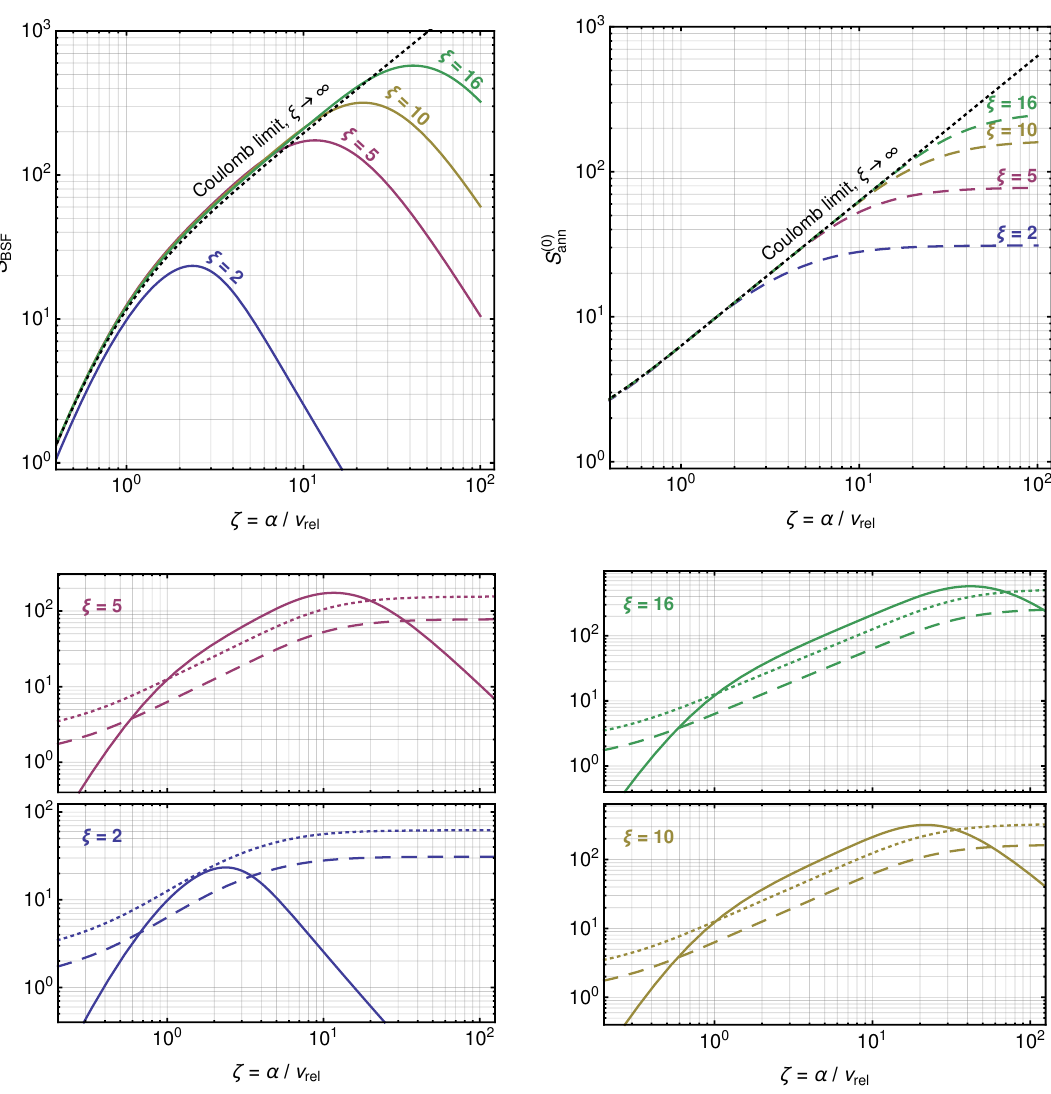
Figure 3b . Velocity dependence of S f 100 g and S (0) ann , for non-resonant values of (cid:24) = (cid:22)(cid:11)=m ’ . BSF When the momentum transfer between the interacting particles drops below the mediator mass, (cid:22)v rel . m ’ (equivalently, (cid:16) & (cid:24) ), the velocity dependence of the cross-sections departs from the Coulombic behaviour. Top left: the cross-section for radiative capture into the ground state with emission of a vector mediator drops approximately as (cid:16) (cid:0) 2 / v 2 (see also (cid:12)gure 5b). Top right: for rel s -wave annihilation processes, the Sommerfeld enhancement saturates to a constant value. Bottom: comparison of the velocity dependence of S f 100 g (solid lines), S (0) ann (dashed lines), 2 S (0) ann (dotted BSF lines), for various values of (cid:24) . For a non-zero mediator mass, and for a particle-antiparticle pair, the bound-state formation cross-section is larger than the annihilation cross-section within a (cid:12)nite range of velocities, roughly m ’ . (cid:22)v rel . (cid:22)(cid:11) , or equivalently 1 . (cid:16) . (cid:24) . (This comparison ignores the phase-space suppression of the bound-state formation